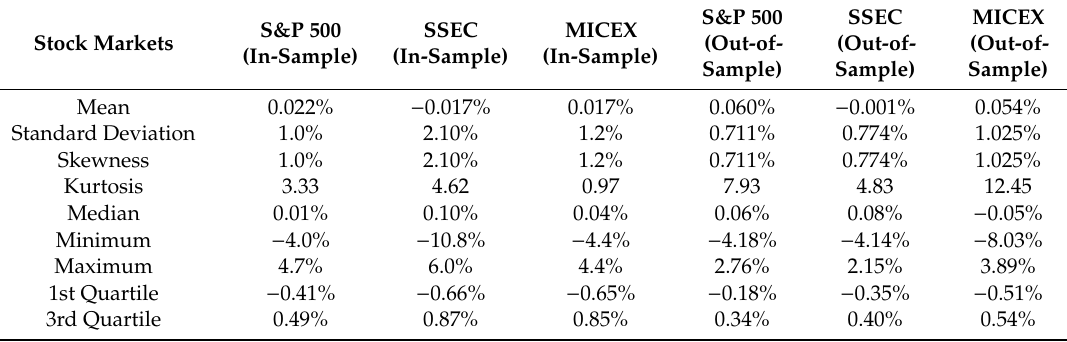
Table 2. Descriptive Statistics of S&P 500, SSEC, and MICEX: 5 January 2015–30 December 2016 and